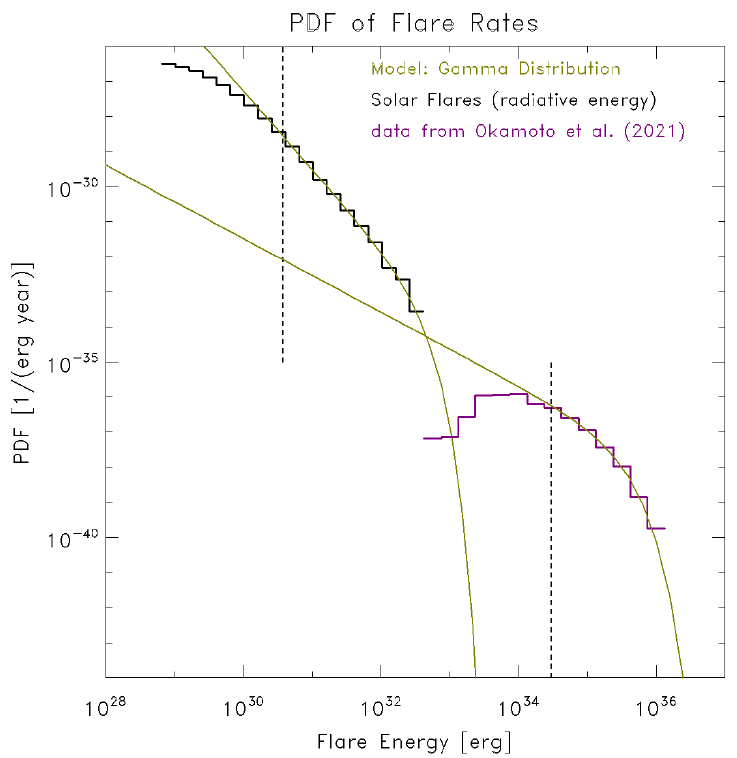
Figure 7. Comparison of solar and stellar flare energy distributions. Black and purple histograms show the occurrence rates of solar X-ray flares and stellar flares [39], respectively. The olive curves are fit to these data by the gamma function distributions. The vertical dashed lines indicate the lower boundary for fitting adopted for the solar flare data (3.8 × 10 30 erg of radiated energy) and for the stellar flare data (3 × 10 34 erg).